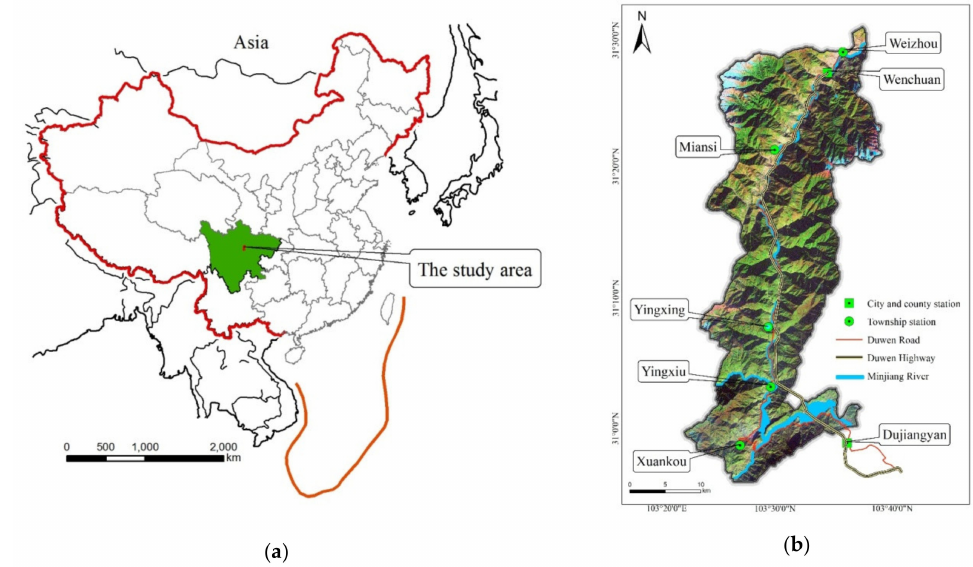
Figure 1. ( a ) Location of the study area, Sichuan Province, China; ( b ) remote sensing image map of Dujiangyan-Wenchuan